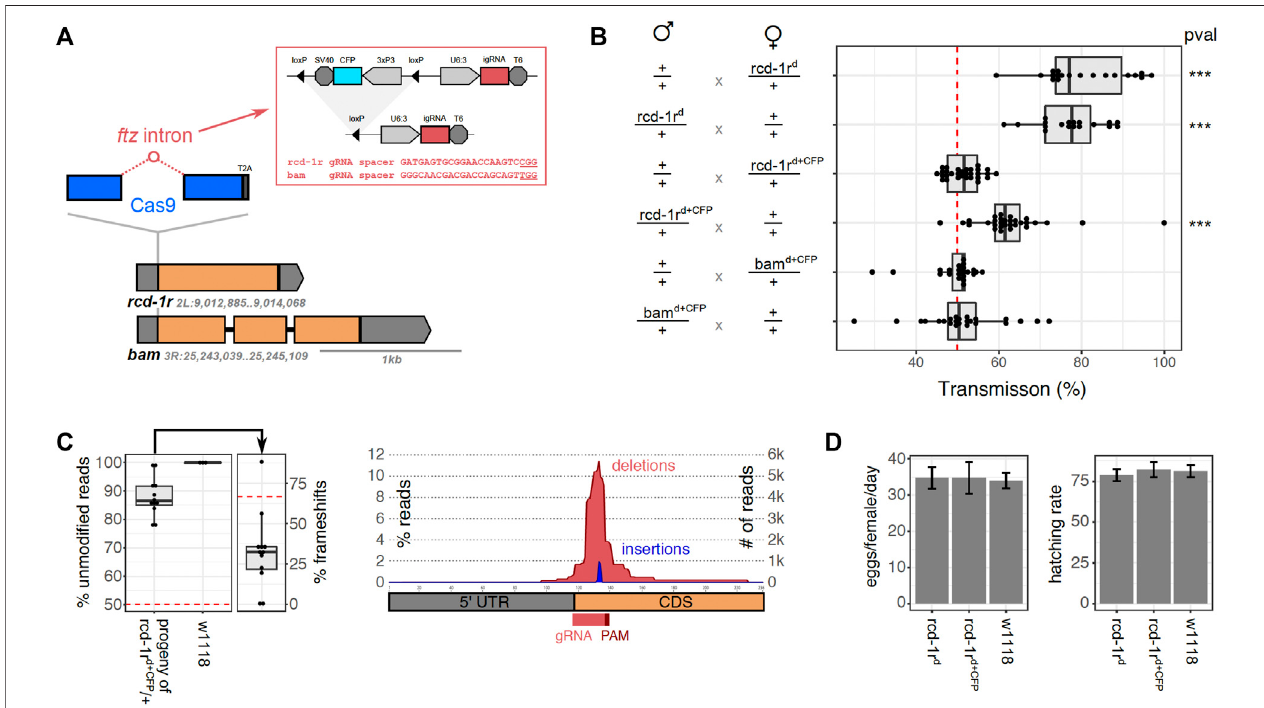
FIGURE 2 | Characterization of integral gene drive traits in transgenic fl ies. (A) Schematic representation showing the design and integration strategy of the Cas9 coding sequence (blue), hosting the ftz intron (red) which in turn contains the gRNA expression cassetteand the excisable CFP marker cassette, at the endogenous loci rcd-1r and bam (orange)towhichitistranslationallylinked(T2A).ThegRNAtargetsequences(red)orthegRNAmodule(redcircle)isindicatedincludingtheprotospacer adjacentmotif(underline). (B) Homingassaysdeterminingtherateofinheritanceofthetransgenetotheprogenyofmaleorfemalehemizygote fl ies.Inheritancewas calculated as the percentage of the fl uorescent progeny ( rcd-1r d+CFP , bam d+CFP ) or by molecular genotyping ( rcd-1r d ). The p values were calculated using one-way ANOVA and Tukey multiple comparisons of means (* p < 0.05; ** p < 0.01; and *** p < 0.001). We performed a minimum of 18 independent crosses per condition. (C) Analysisof rcd-1r targetsiteampliconsfromthepooledprogenyof rcd-1r d+CFP hemizygotemales(n=12)anda w1118 wild-typecontrol(n=3).Theleftpanelshowsthe median number of modi fi ed reads and the number of target site variants that are predicted to cause a frameshift. The right panel shows the size distribution of modi fi ed positions around the gRNA target site. (D) Analysis of fertility and fecundity of gene drive fl ies. The left panel shows an analysis of oviposition for homozygous transgenic strains rcd-1rd + CFP , rcd-1r d and control fl ies performed in at least 10 independent crosses. The mean and the standard error of the mean for the number of eggs laid perfemale,perday(leftpanel),aswellastherateofeggshatchingtobecomeadults(rightpanel)areshown.Nostatisticallysigni fi cantdifferencewasfoundamongstthe strains using one-way ANOVA and Tukey multiple comparisons of means (* p < 0.05; ** p < 0.01; and *** p <